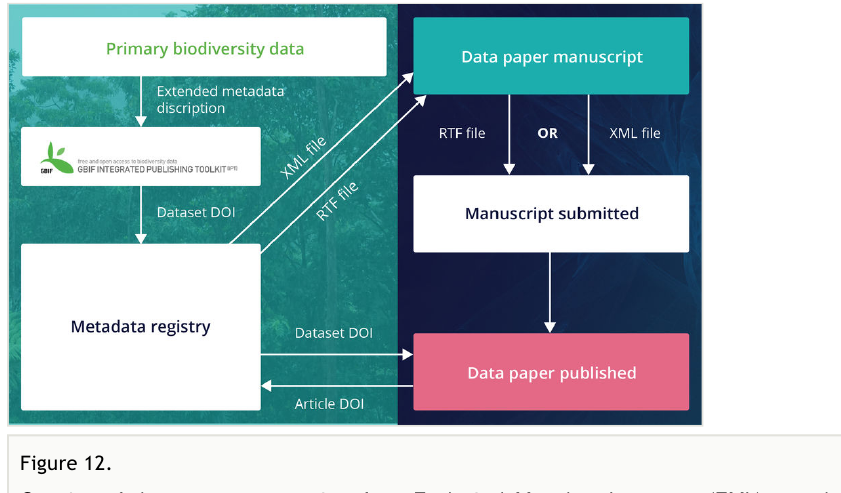
Figure 12. Creation of data paper manuscripts from Ecological Metadata Language (EML) metadata hosted at the GBIF